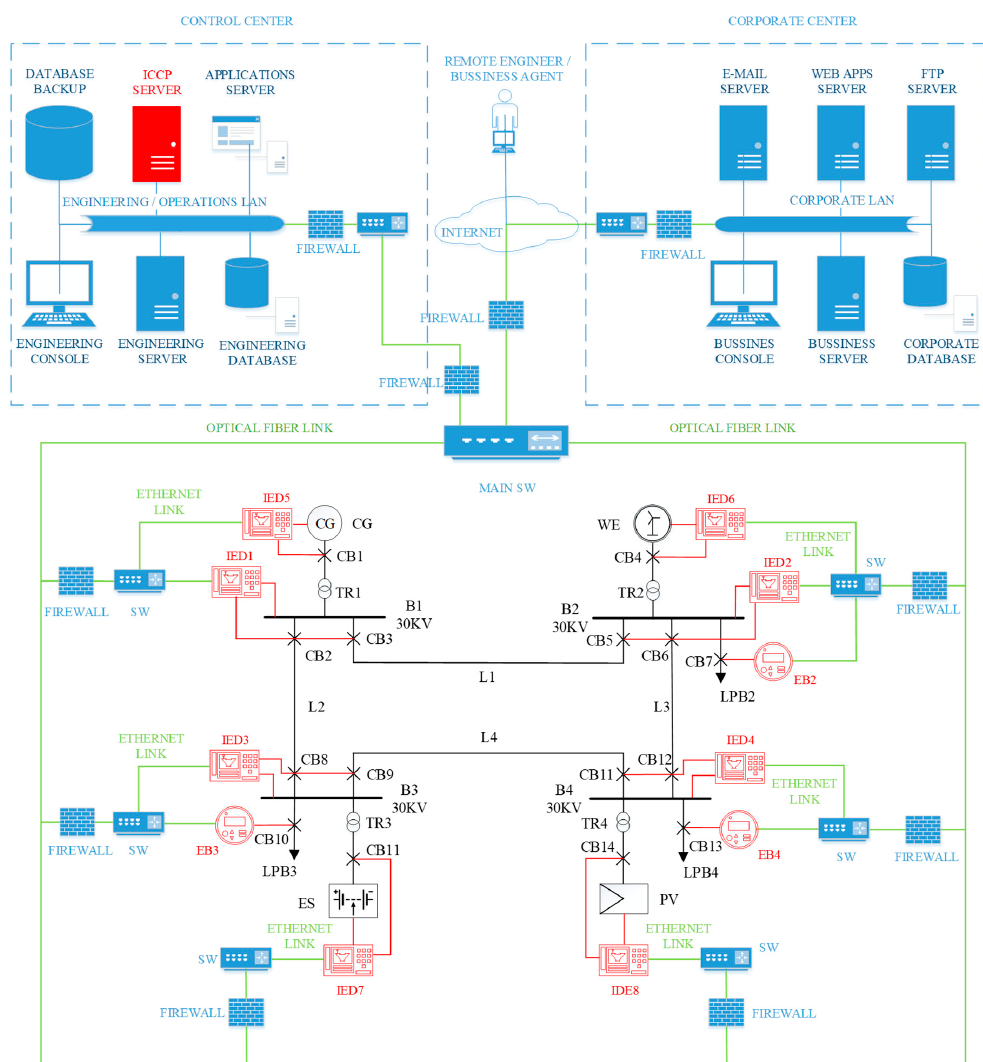
Figure 2 . Schematic diagram of the cyber-power network representing the smart grid test system [43]. A 110 MW conventional generation station (CG) is connected to busbar B1. Distributed